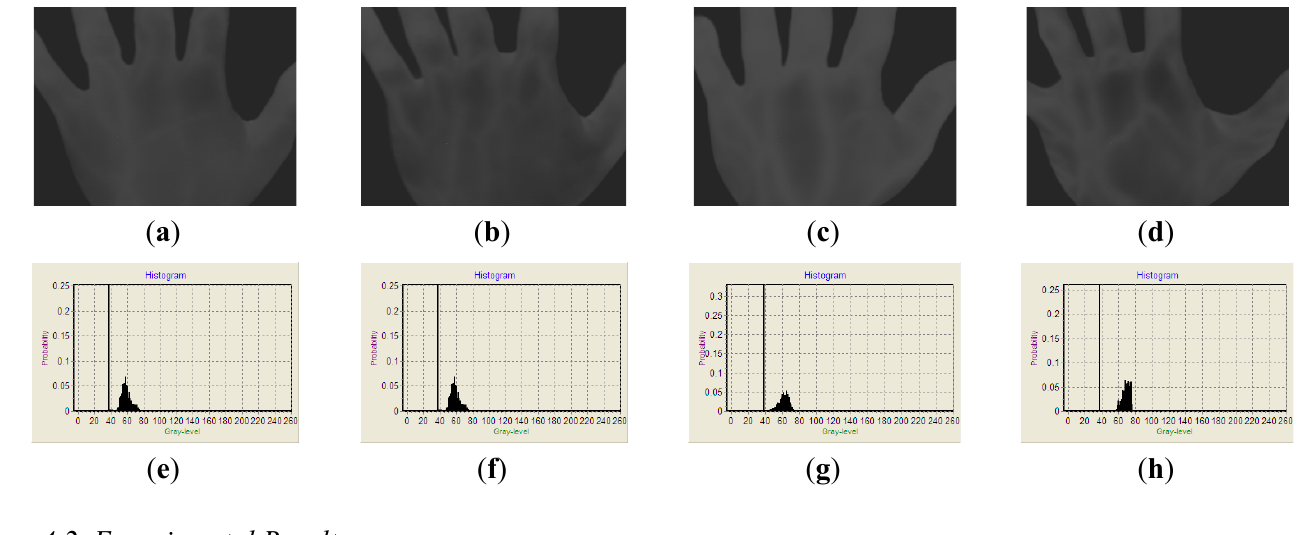
Figure 2. Images ( a – d ) demonstrate the thermal images captured from four different palm-dorsa. Images ( e – h ) show the corresponding histograms of